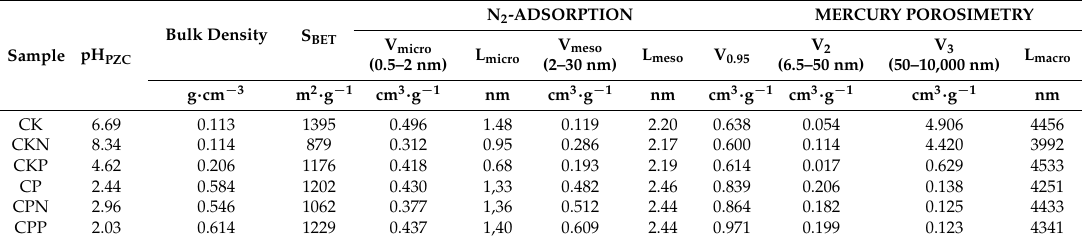
Table 3. Textural proprieties and point of zero charge (pH PZC ) of activated carbons prepared by chemical activation of olive stones with potassium hydroxide (CK) and phosphoric acid (CP).